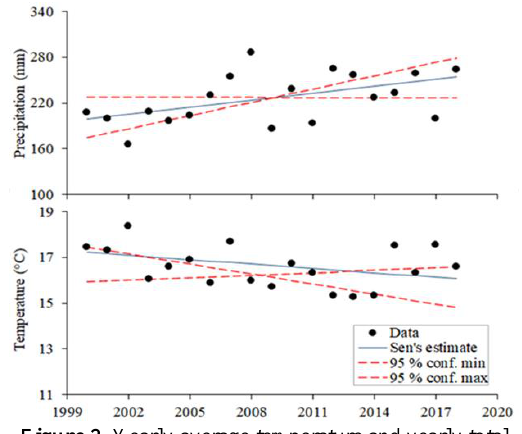
Figure 2. Yearly average temperature and yearly total precipitation for the period 2000-2018 (from June to August) at